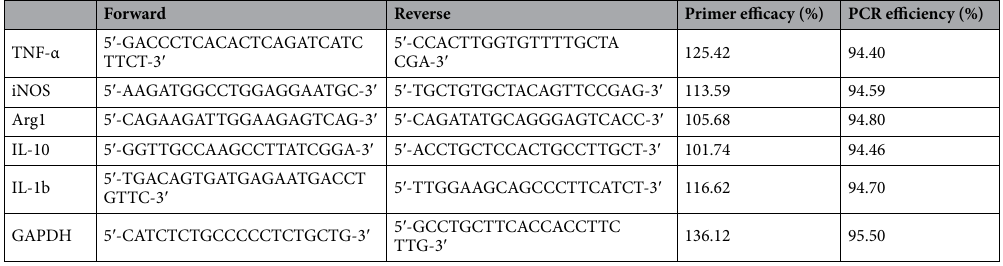
Table 1. Specific forward and reverse